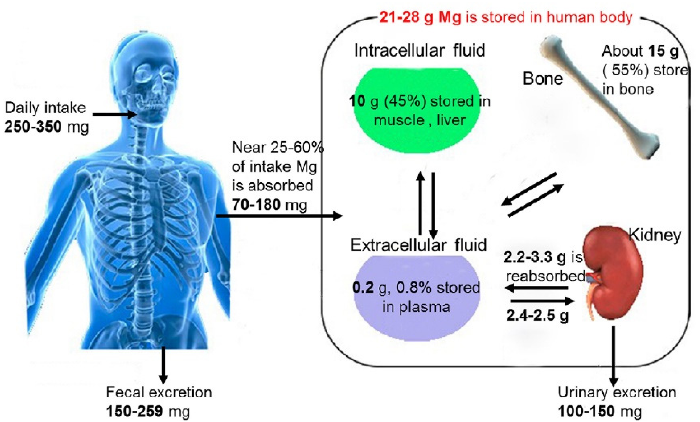
Figure 2. The diagram illustrates the dynamic absorption and excretion of Mg in the human body. Reproduced with permission from [58]. Copyright 2019, Elsevier.